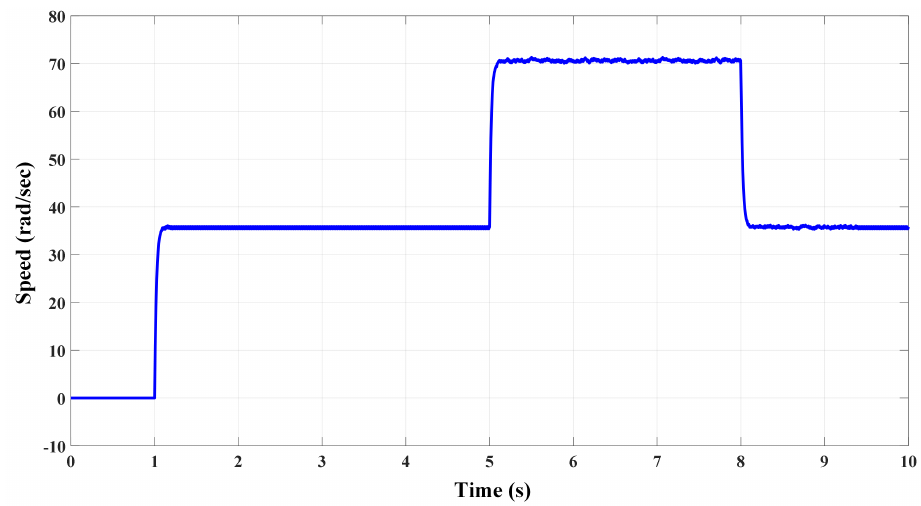
Figure 13. Speed response for different reference jumps of the torque.